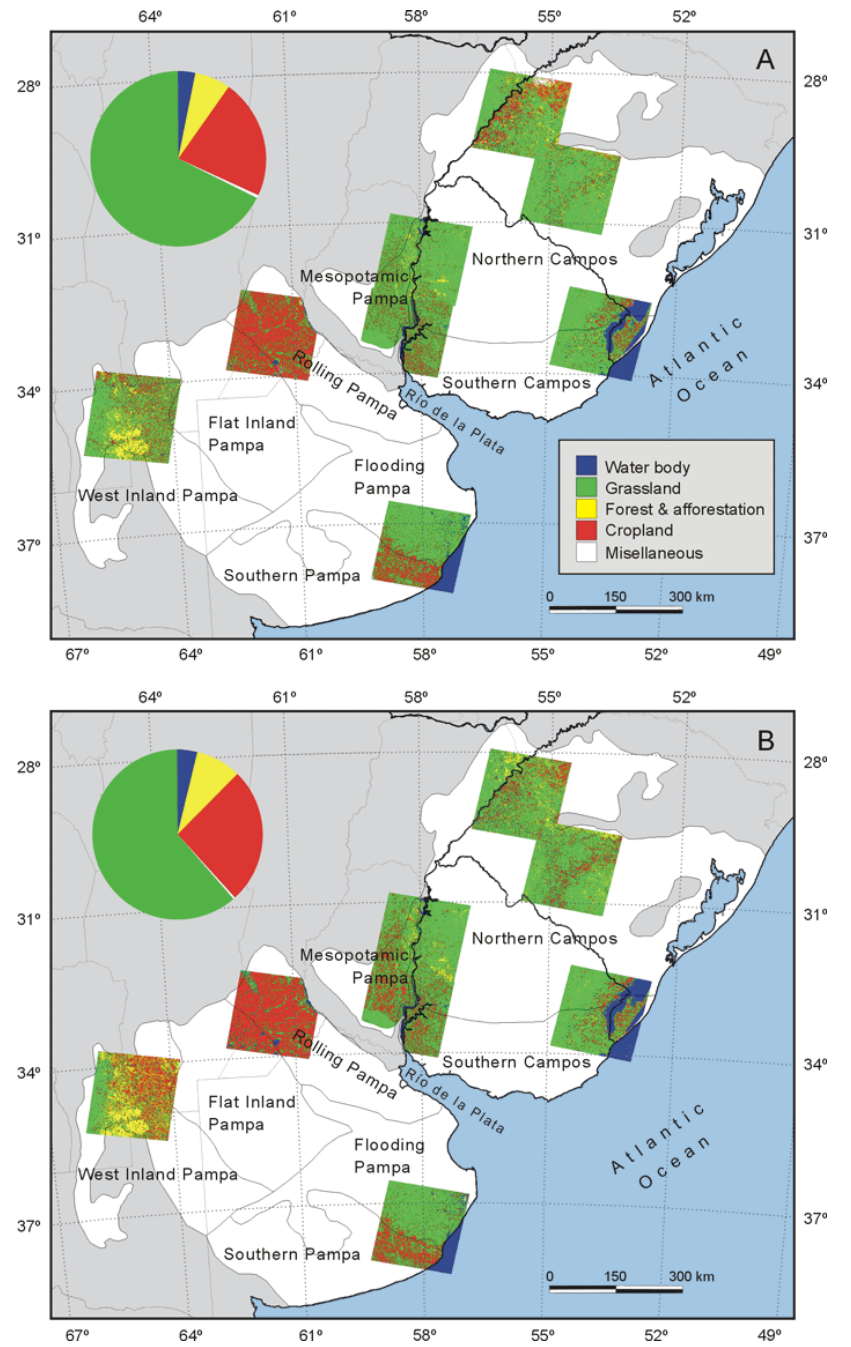
Fig. 2. Land-use and land cover maps for (A) 1985–1989 and (B) 2002–2004. Light gray lines indicate subunit boundaries. The pie chart indicates the percentage of each land-use and land cover type for each